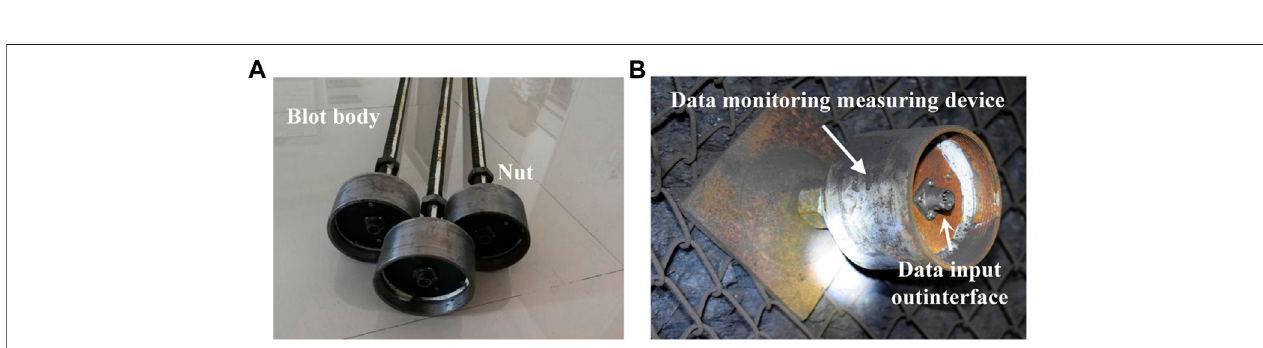
FIGURE 9 | Force measuring bolt: (A) force measuring bolt in the laboratory; and (B) force measuring bolt installed on site.